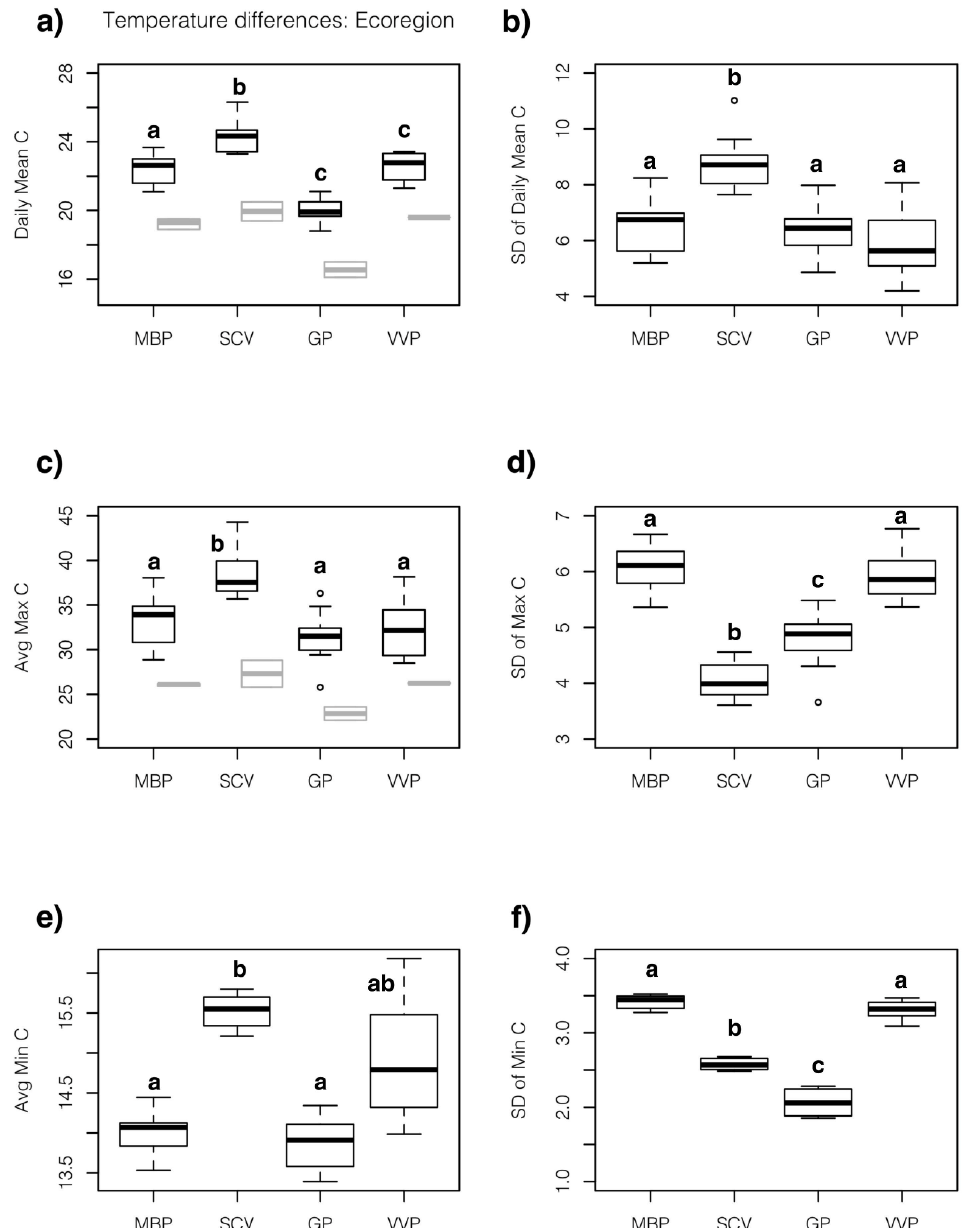
Figure 3. Average, maximum and minimum temperatures and their variation as measured by standard deviation (SD) in the gardens for the ecoregional models ( a – f ). In gray, available WorldClim v2 Bioclim data plotted for a context of long-term temperature averages ( a , c ). WorldClim data are the mean temperature of the warmest quarter (BIO9) ( a ) and the maximum temperature of the warmest month (BIO5) ( c ). Box-and-whisker plots of the grouped values indicate the median, maximum, minimum, and 75% and 25% quantiles. Circles indicate outliers. Different lowercase letters indicate statistically significant differences between local-scale temperature measurements (from logger data) among ecoregions assessed using post-hoc tests. (California: MBP, Monterey Bay Plains; SCV, Santa Clara Valley; Melbourne: GP, Gippsland Plain; VVP, Victorian Volcanic Plain).